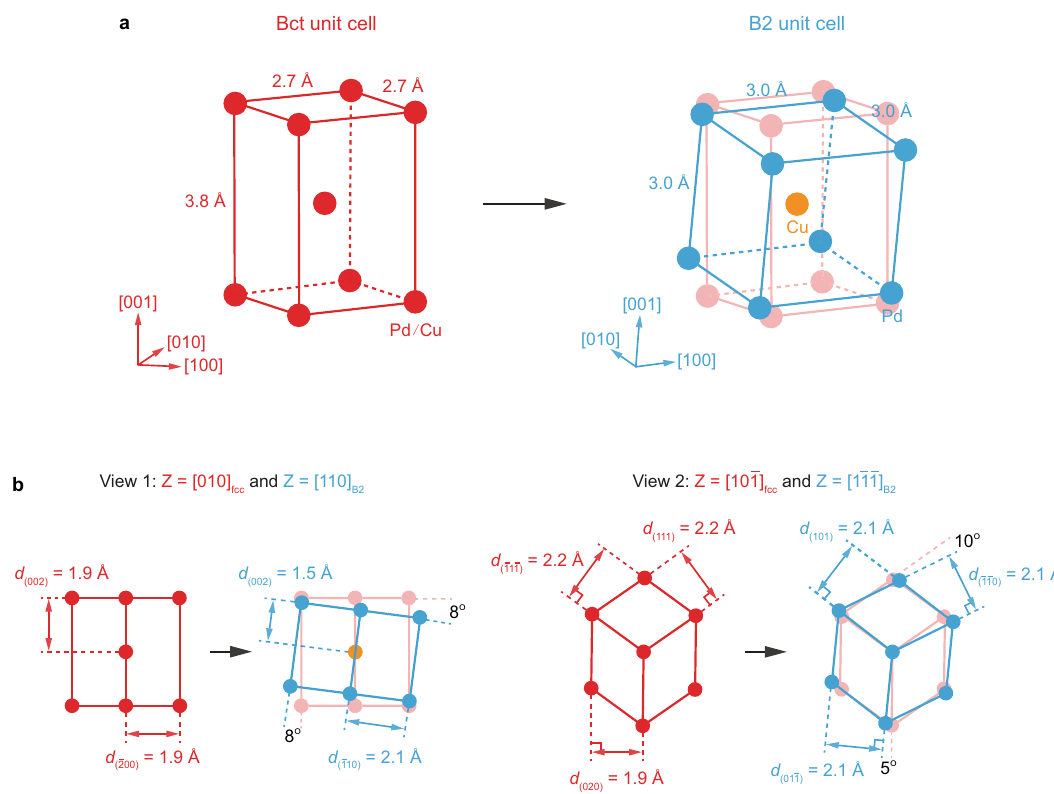
Fig. 3 | Schematic offcc-to-B2phase transition. a The atomic con fi gurations of a body-centered tetragonal (bct) (red) and B2 (blue) unit cells with respective dimensionsof2.7×2.7×3.8Å 3 and3.0×3.0×3.0Å 3 .Thebctunitcellisconstructed from two disordered fcc unit cells with the dimension of 3.8×3.8×3.8Å 3 (Sup- plementary Fig. 6a). The fcc-to-B2 phase transition occurs via continuous